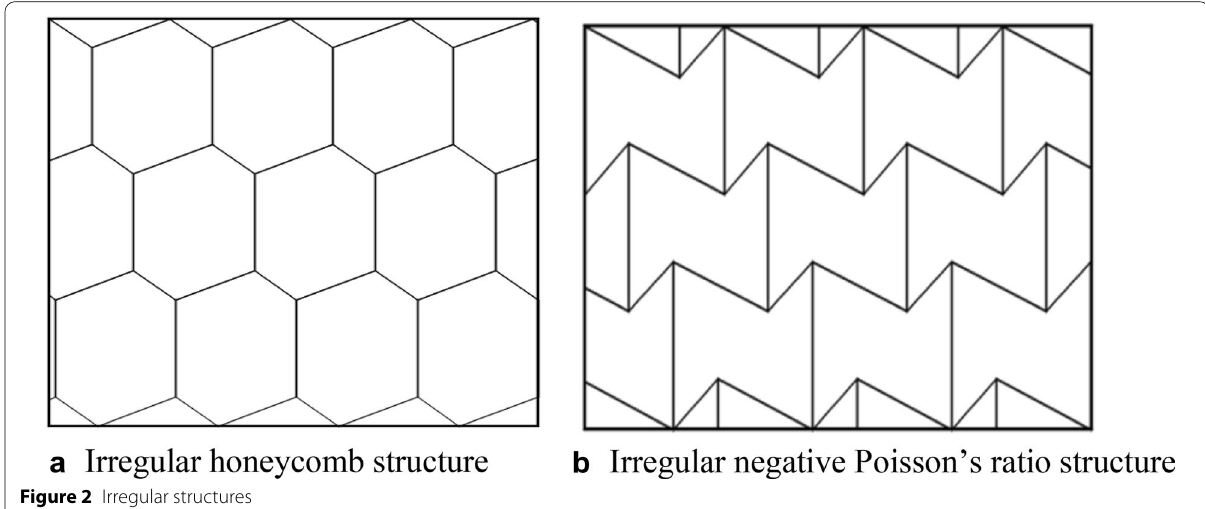
Figure 2 Irregular structures